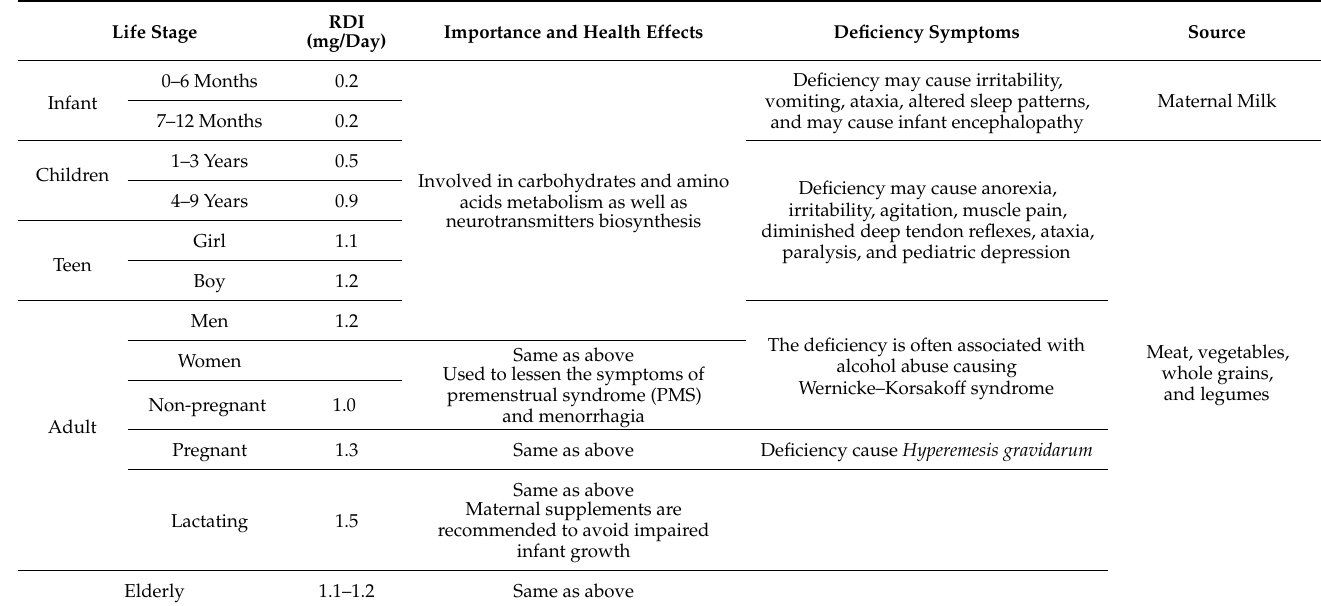
Table 1. Recommended daily intake (RDI), main action, and natural sources of vitamin B1 (thiamine) in different life